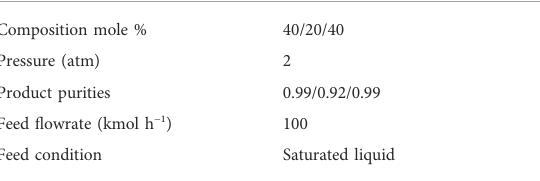
TABLE 1 Feed conditions for Example